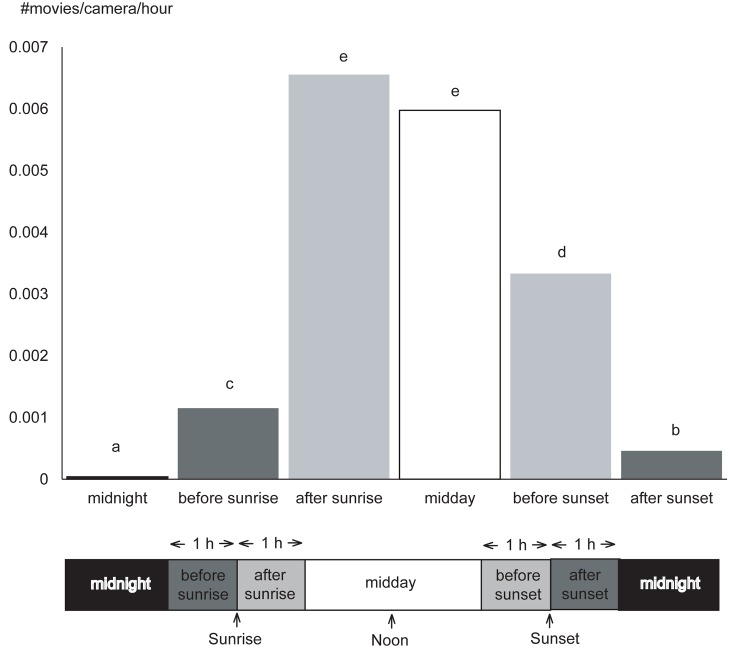
Capture rate of Japanese macaques in the six daily time periods.Significant differences among the time periods (indicated by χ2 tests with Bonferroni corrections) are indicated by different lowercase letters in the order a<b<c<d<e.